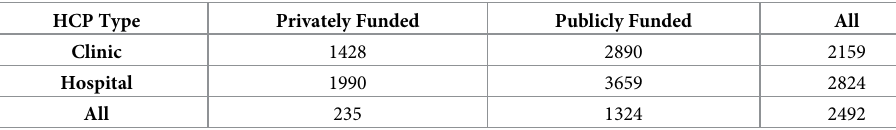
Table 3. Mean standard deviation of AI for all HCPs across all